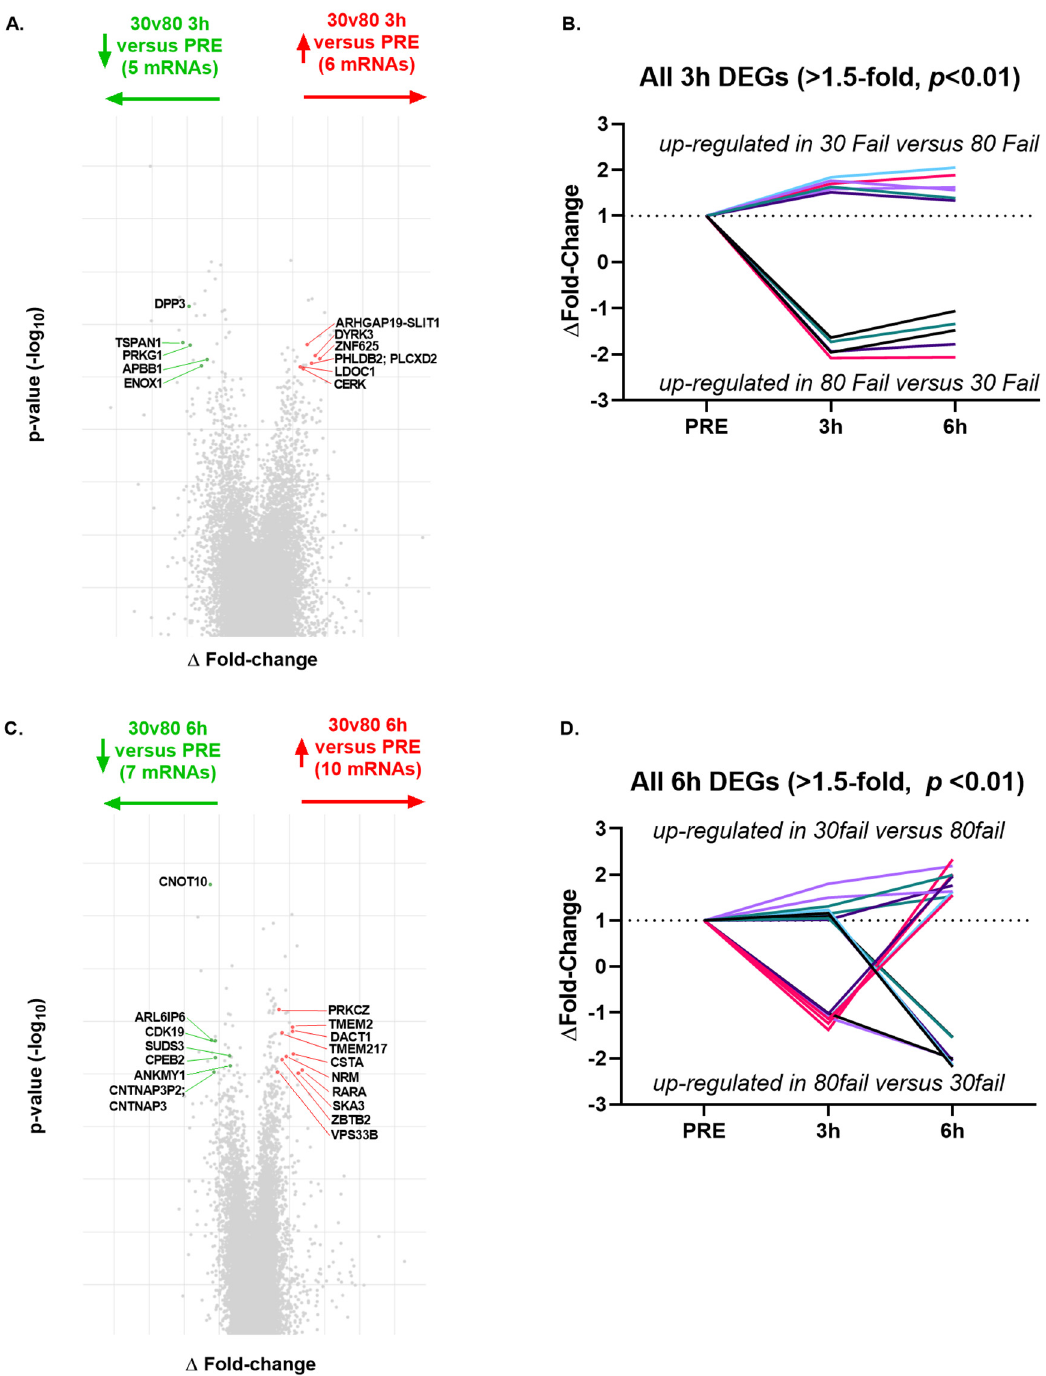
Figure 6. Differentially expressed mRNAs between bouts at both post-exercise time points. All data are significant differentially-expressed genes (DEGs) following 30 Fail versus 80 Fail for the ∆ Fold-change in gene expression plotted against p -value ( − log 10 transformed) at 3 h POST versus PRE (panel A ), the ∆ Fold-change over time for significant DEGs at 3 h POST versus PRE (panel B ), the ∆ Fold-change in gene expression plotted against p -value ( − log 10 transformed) at 6 h POST versus PRE (panel C ), and the ∆ Fold-change over time for significant DEGs at 6 h POST versus PRE (panel D ). Data are for n = 11 participants and the significance threshold was established as ± 1.5 ∆ Fold-change, p < 0.01. Abbreviations: 30 Fail, 30% one repetition maximum to failure bout; 80 Fail, 80% one repetition maximum to failure